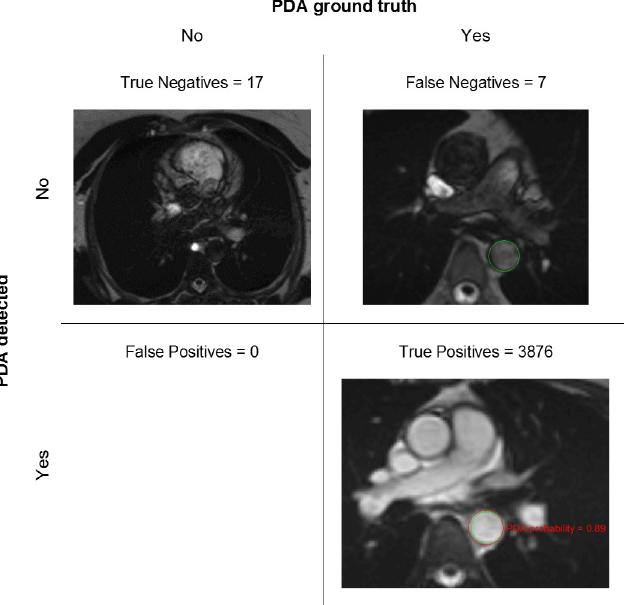
Fig 9. Confusion matrix for PDA detection (with example images). Mean error = 0.18% (CI = 0.15–0.26%) estimated from RF training repetitions. Green circles represent the ground truth and red circles the automatically detected ROIs. Total number of scans in the test dataset = 3900.